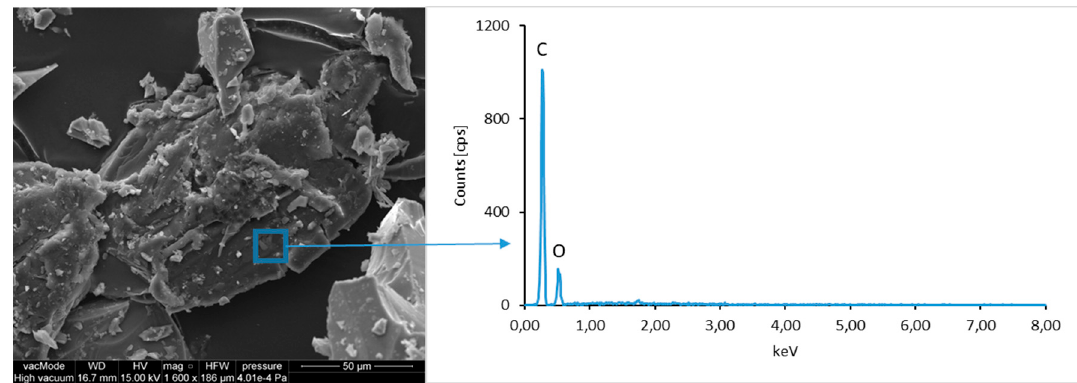
Figure 9. Scanning electron microscopy (SEM) micro-structure of an LCD panel and results of elemental analysis in energy dispersive spectroscopy (EDS) micro-area.